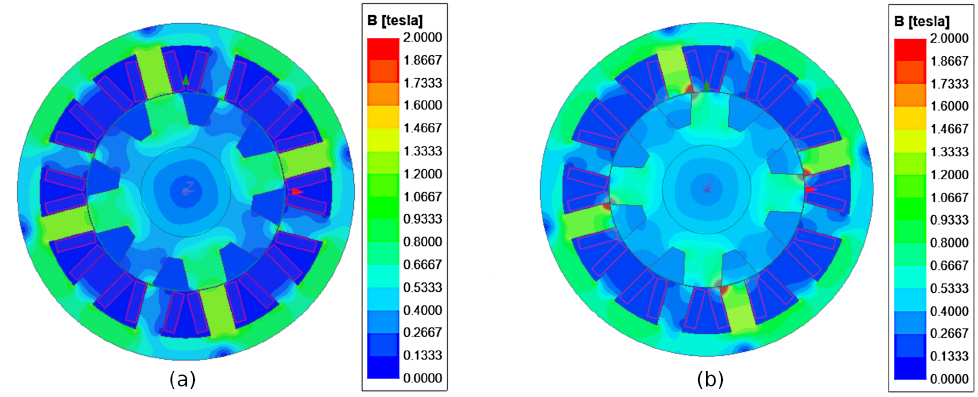
Figure 5. Magnetic flux distribution of HESRM: ( a ) aligned poles and ( b ) unaligned